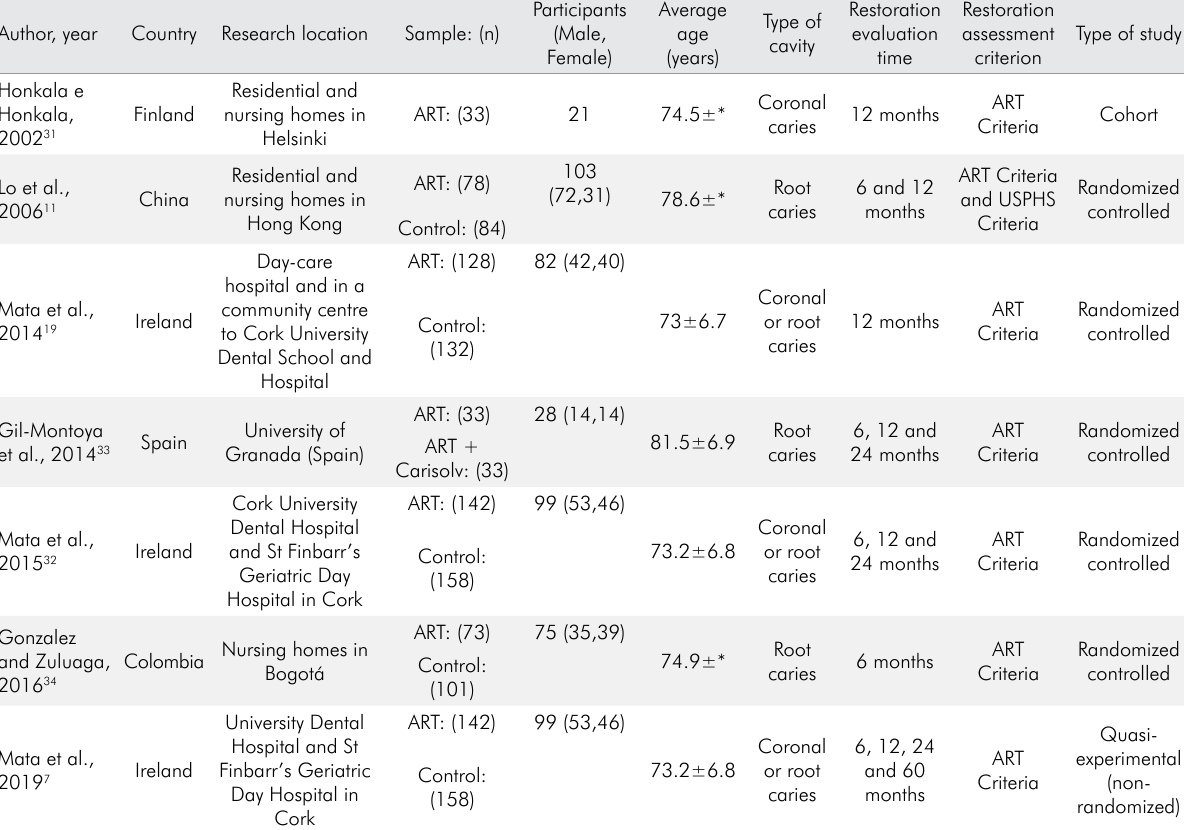
Table 2. Summary of the main characteristics of the eligible studies included on qualitative